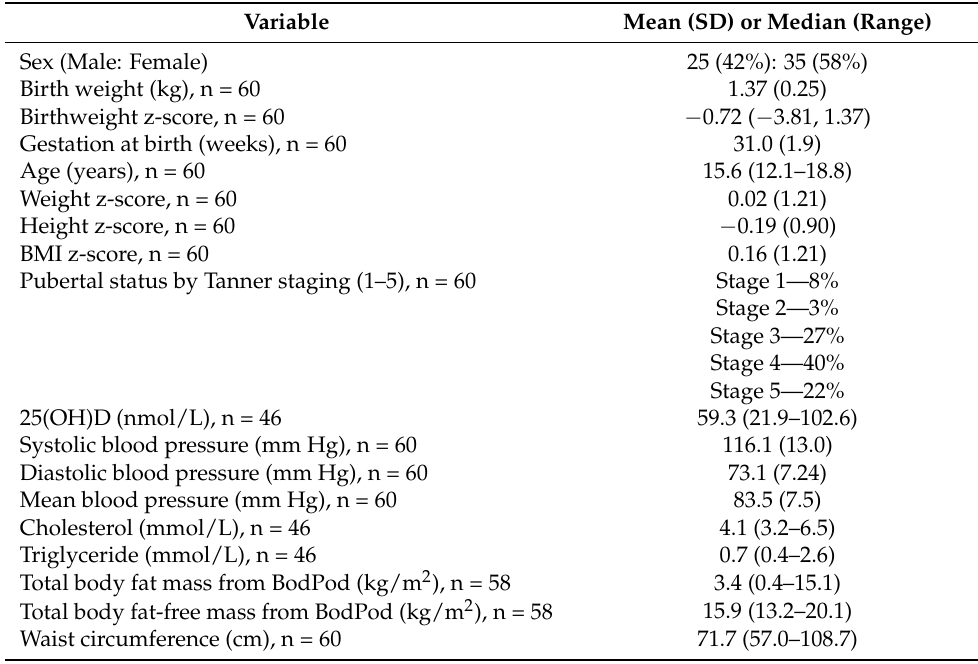
Table 1. Subject characteristics at birth and time of follow-up and auxology, body composition and biochemistry at study visit. BMI: body mass index, SD: standard